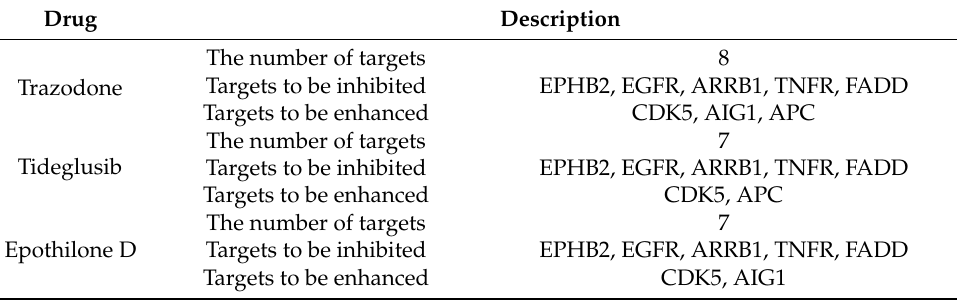
Table 2. The multiple-molecule drug for the later stage AD. Drug Description The number of targets 8 Targets to be inhibited EPHB2, EGFR, ARRB1, TNFR, FADD Trazodone Targets to be enhanced CDK5, AIG1, APC The number of targets 7 Tideglusib Targets to be inhibited EPHB2, EGFR, ARRB1, TNFR, FADD Targets to be enhanced CDK5, APC The number of targets 7 Epothilone D Targets to be inhibited EPHB2, EGFR, ARRB1, TNFR, FADD Targets to be enhanced CDK5,